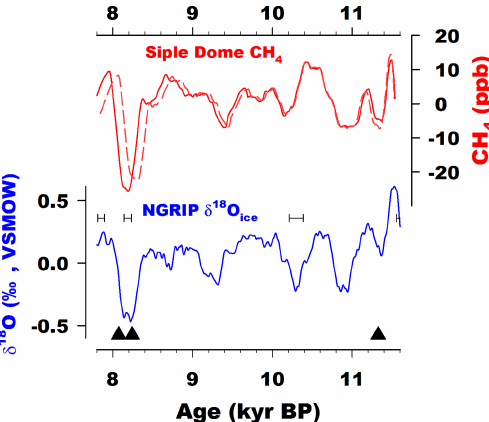
Figure 3. Top: comparison between Siple Dome CH 4 anomalies plotted with gas age adjusted to GICC05 (red, solid) and previous gas age (red, dashed; Brook et al., 2005). Bottom: NGRIP δ 18 O anomaly in GICC05 scale. The horizontal error bars denote the age uncertainty of GICC05 chronology (Rasmussen et al., 2006), and the black triangles are age tie points used to adjusting the Siple Dome age scale to GICC05 scale.